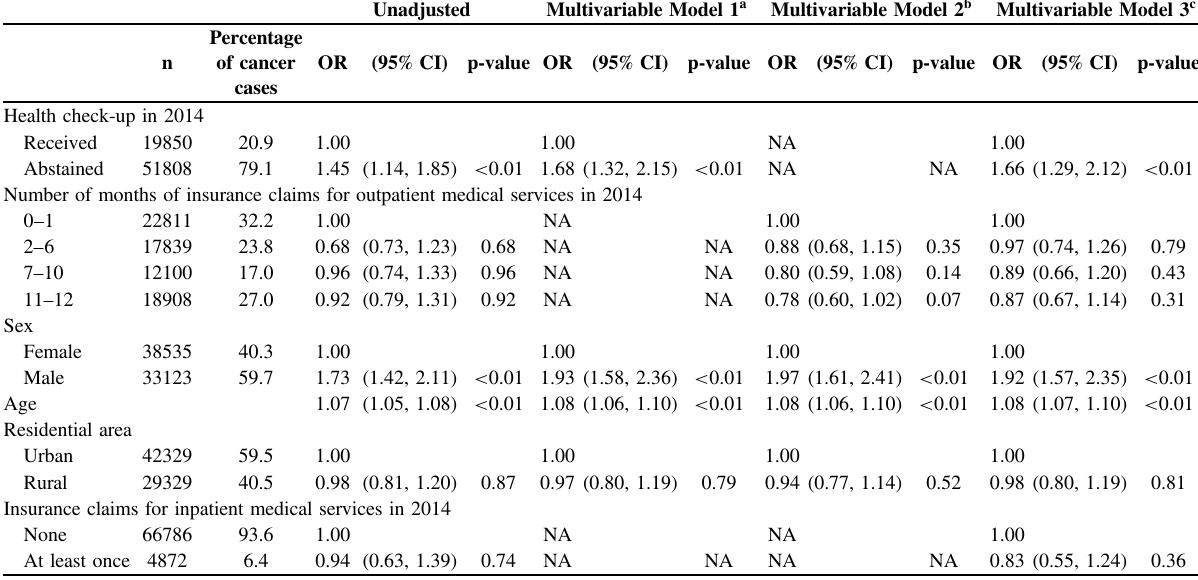
Table 3 Association between predictors and advanced cancer diagnosis (N = 71,658; 407 cancer